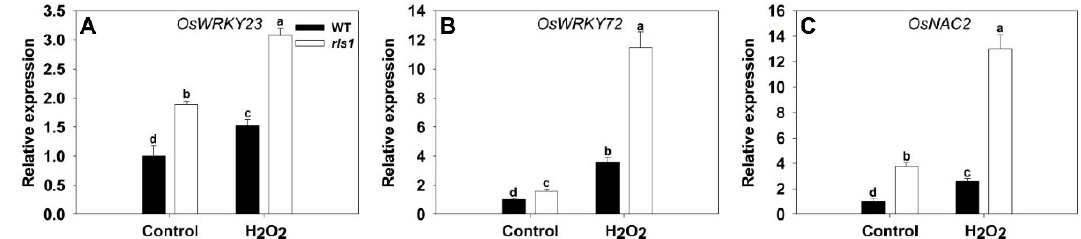
Figure 9. The transcriptional response of SATFs (senescence-associated transcription factor genes) in WT and rls1 plants subjected to oxidative stress. ( A ) OsWRKY23 ; ( B ) OsWRKY72 ; ( C ) OsNAC2. For normalization purposes, the transcript abundance of each SATF in non-stressed WT was set to 1. Values expressed in the form mean ± SE ( n = 3). Significant differences between means ( p < 0.05) indicated by different letters.